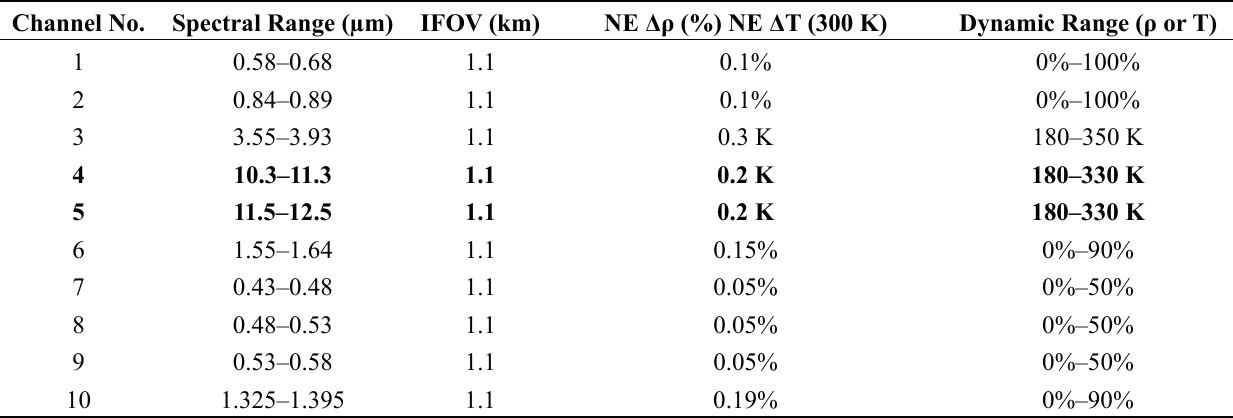
Table 1. Specifications of the VIRR channels: spectral ranges and spatial resolutions. IFOV, instantaneous field of view; NE Δ T, noise-equivalent temperature